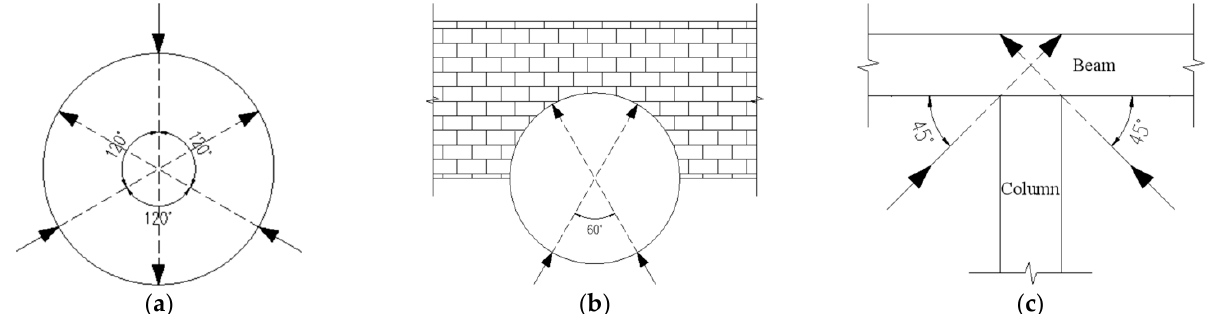
Figure 6. Internal damage detection method; ( a ) fully exposed column; ( b ) half exposed column; ( c ) beam-column joint. After the end of the test, the internal damage of the timber components can be deter- mined by the instrument display spectrum. The resistance maps of the timber components without damage are more stable and uniform, the frequency is faster, the cycle is stable, and the peak-wave trough phenomenon continuously appears. At the crest of the curve, the density of the timber is higher, and it is latewood. At the trough of the curve, the timber density is smaller, and it is earlywood (Figure 7a). When there are decayed areas in the timber, the mechanical properties change, the strength and hardness decrease to varying degrees, and the resistance to the needle also decreases. As a result, the resistance map of the area appears to fluctuate and it declines more obviously with a slower slope area in the process (Figure 7b). If there are hollows or cracks in the timber structure, the needle suddenly receives no resistance in this area, the curve drops steeply, and the map